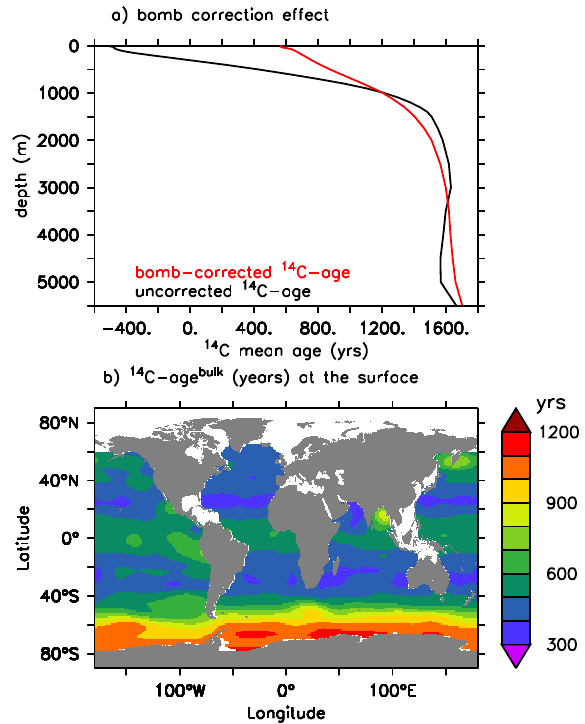
Figure 1. (a) Global mean profiles (GLODAP) of bulk 14 C-age (red) and the pseudo age of 14 C-DIC not corrected for the effects of bomb and anthropogenic 14 C signatures. (b) Map of bulk 14 C-age at the surface of the ocean